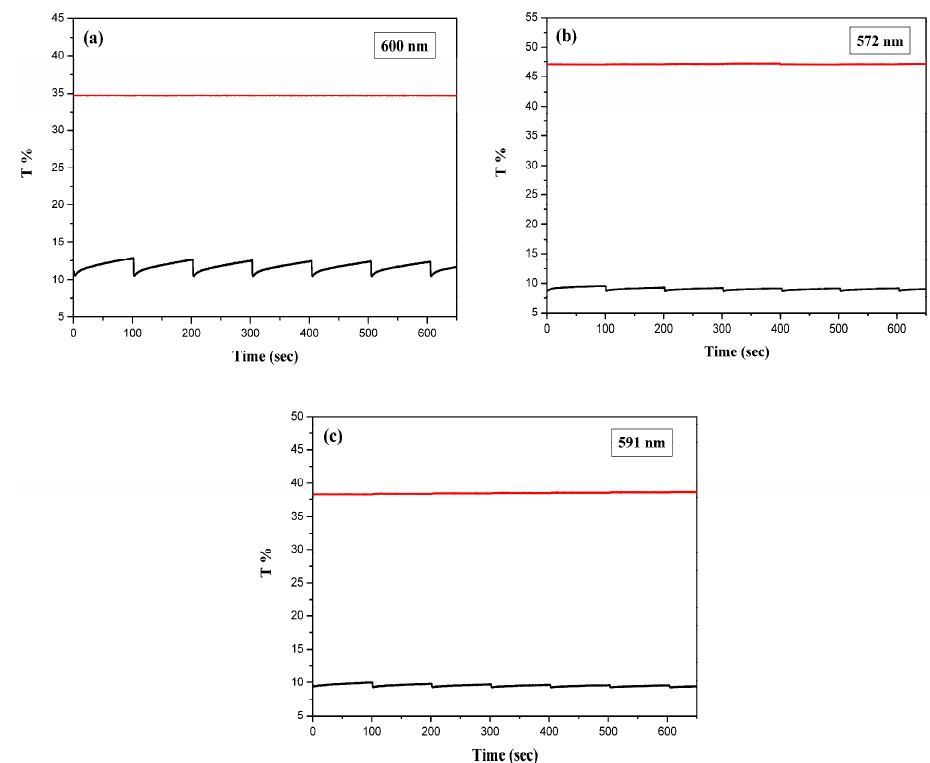
Figure 9. Open circuit stability of ( a ) PtCz/PEDOT ( b ) PtCz/PProDOT-Me 2 , and ( c ) PtCz/PProDOT-Et 2 ECDs at 0.0 V and 1.8 V. The working electrode is PtCz film-coated ITO glass substrate.